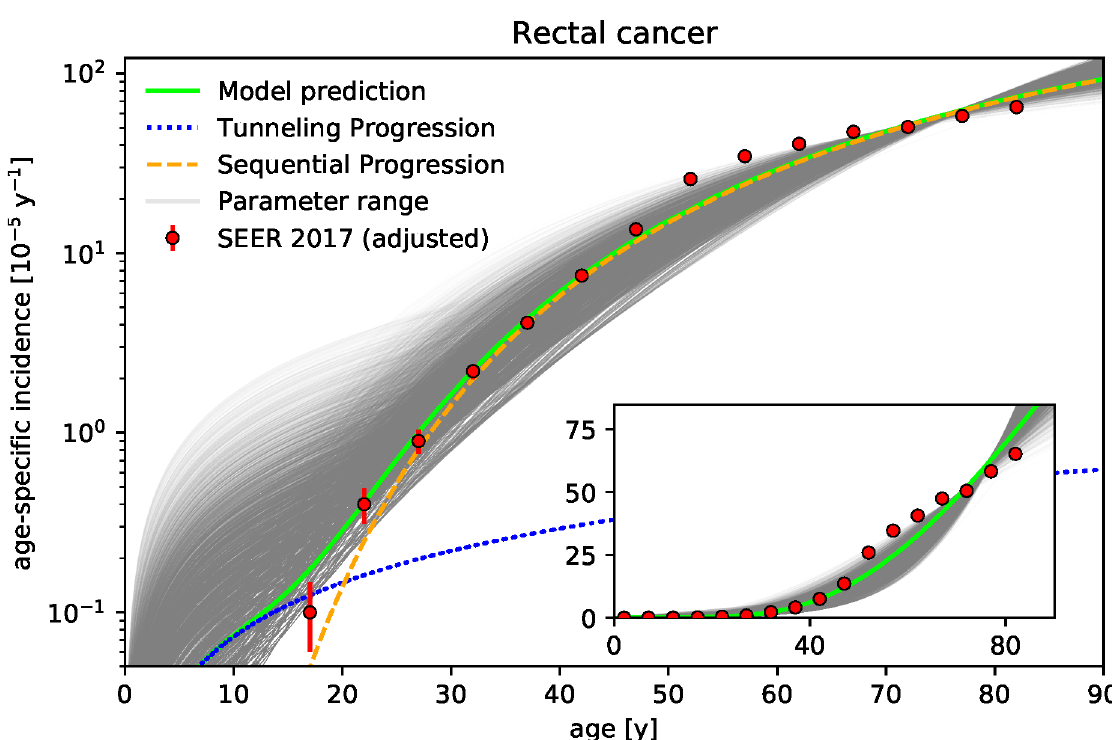
Fig 4. Niche competition model corresponds well to age-specific incidence rates of rectal cancer for age groups below 50. Age-specific incidence rates of rectal cancer predicted by the model shows rough correspondence with epidemiological data (SEER database [33], displayed curves and points analogous to Fig 1). Same parameters as for the the colon are assumed, see Table 1, except for the number of crypts K which is assumed to be ten times smaller K = 10 6 − 2 � 10 6 reflecting that the rectum has on average a tenth of the length of the colon. Exemplary parameter set with N = 8, K = 10 6 , u = 1.75 � 10 − 6 , v = 1.75 � 10 − 6 , and γ = 5% is highlighted in green. The effective replacement rate λ is found to be considerably smaller than replacement rates of colonic crypts ( λ = 0.05 y − 1 per stem cell for the green curve and λ = 0.04 ± 0.02 y − 1 for the gray curves illustrating the parameter